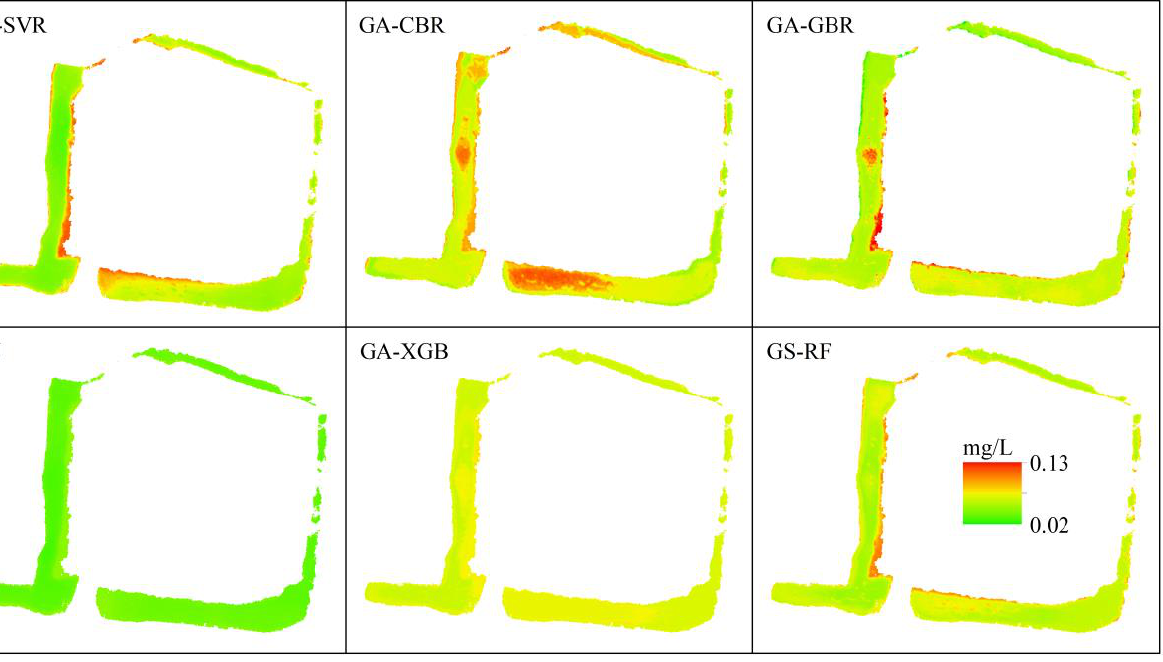
Figure 5. Spatial distribution of TP concentration derived from the six IOA-ML models in research area A.